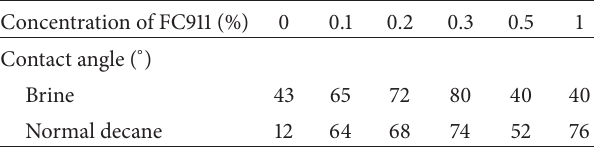
Table 2: Contact angle of the sandstone after treated with FC911. Concentration of FC911 (%) 0